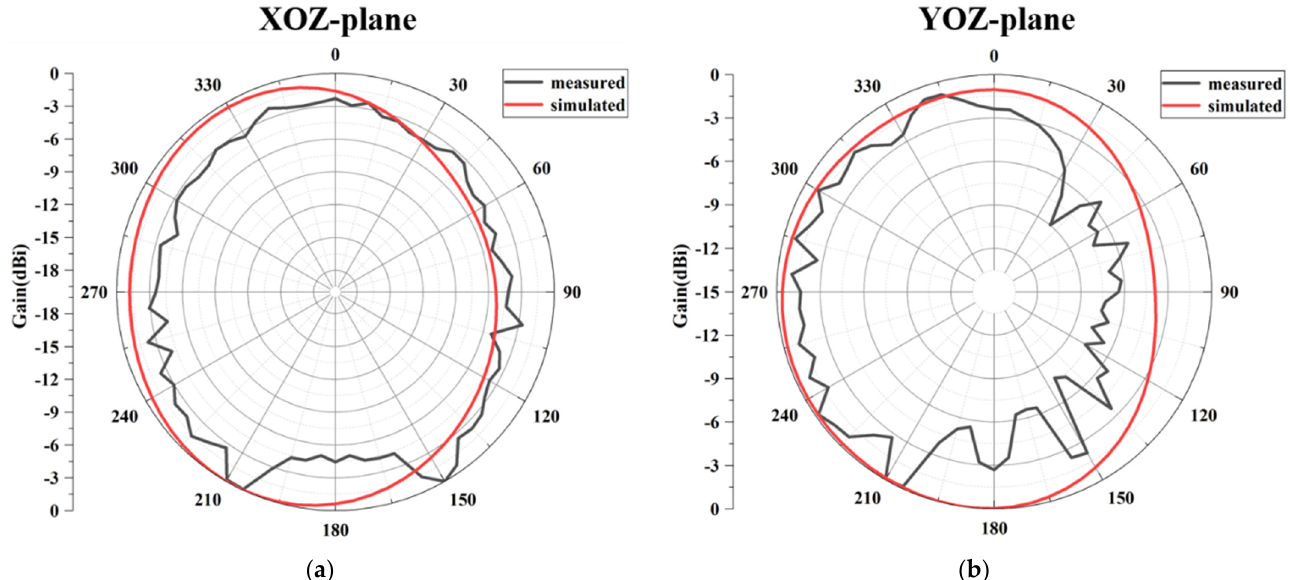
Figure 19. The simulated and measured normalized radiation patterns at 3.45 GHz: ( a ) XOZ plane; ( b ) YOZ plane.